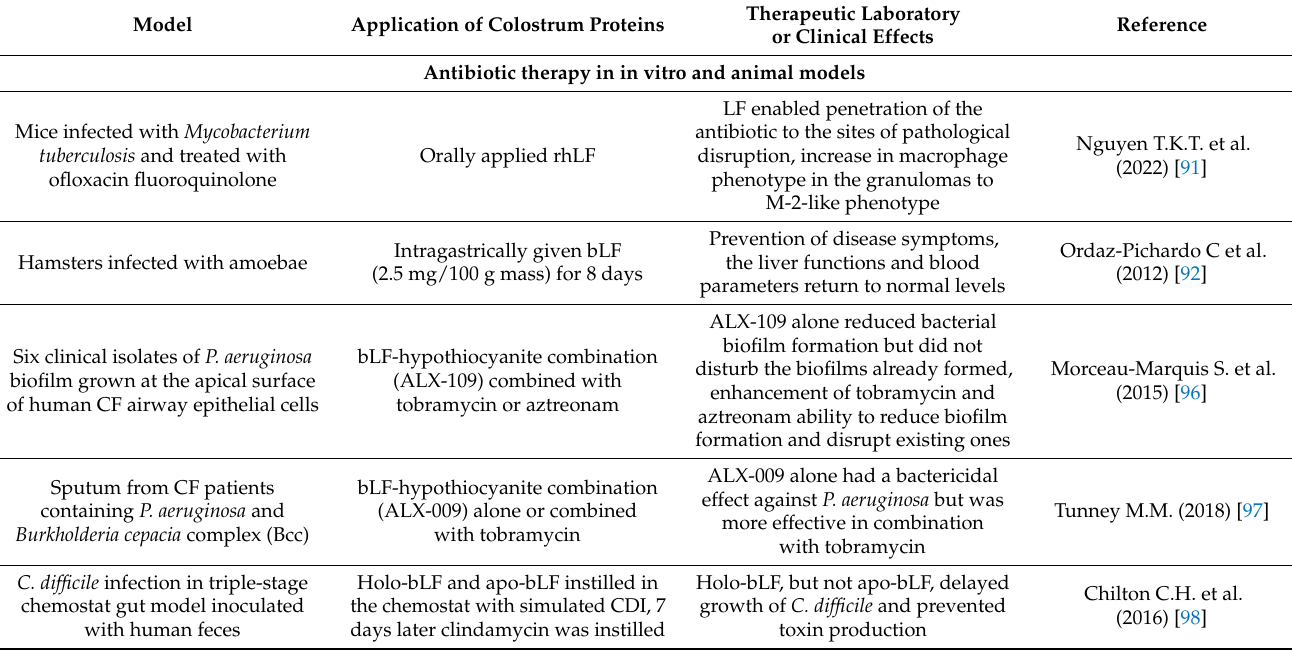
Table 1. Protective and therapeutic effects of whole BC and LF (bovine and human) as additive therapies in antibiotic, NSAID therapy, synthetic steroid therapy and psychophysical stress (generated by endogenous steroids). In vitro/ex vivo, animal and human studies are